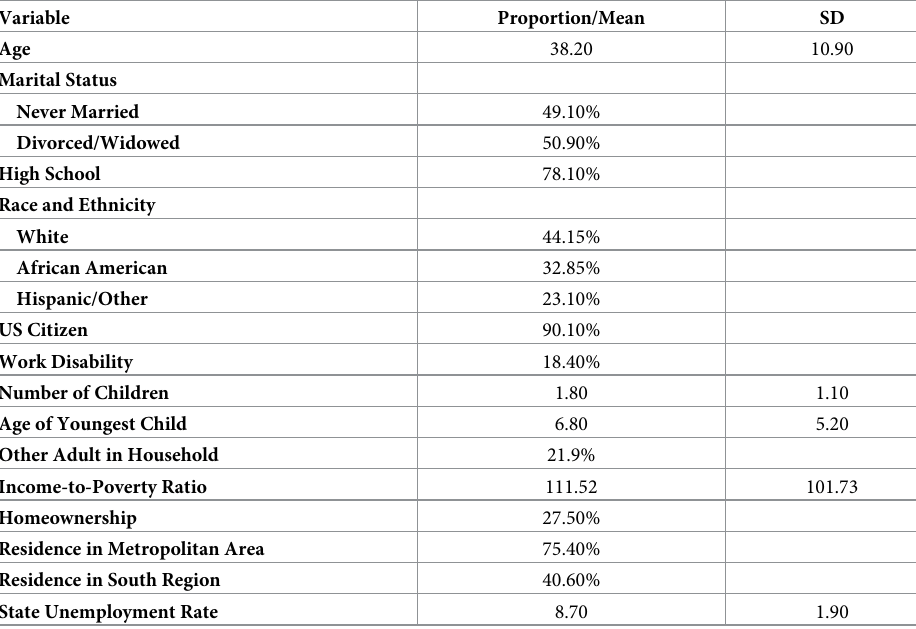
Table 1. Sample characteristics of single mothers ( N =